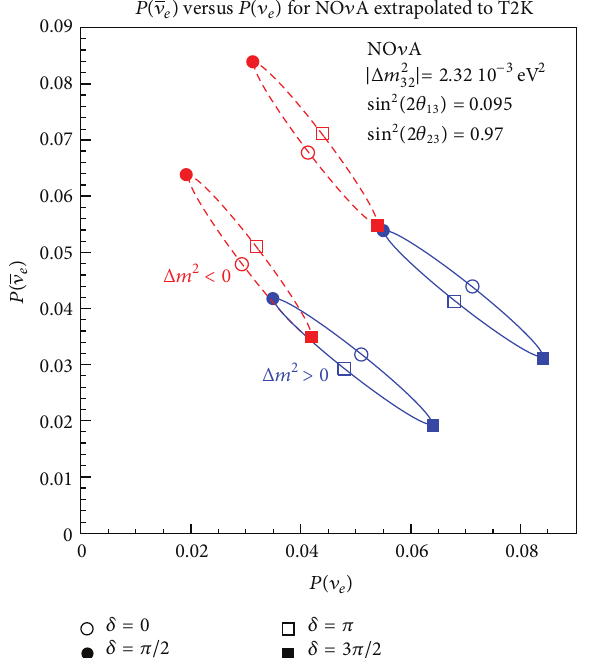
Figure 31: Biprobability plot for sin 2 (2𝜃 23 ) = 0.97 for T2K.